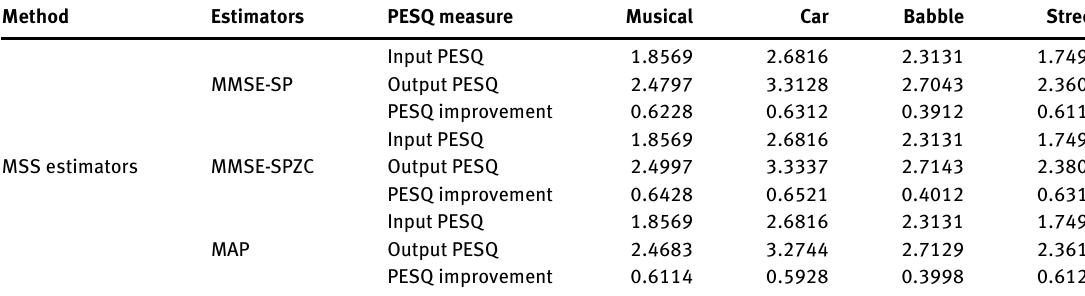
Table 6: Performance Measurement of MSS Estimators in Terms of PESQ for TIMIT Database.